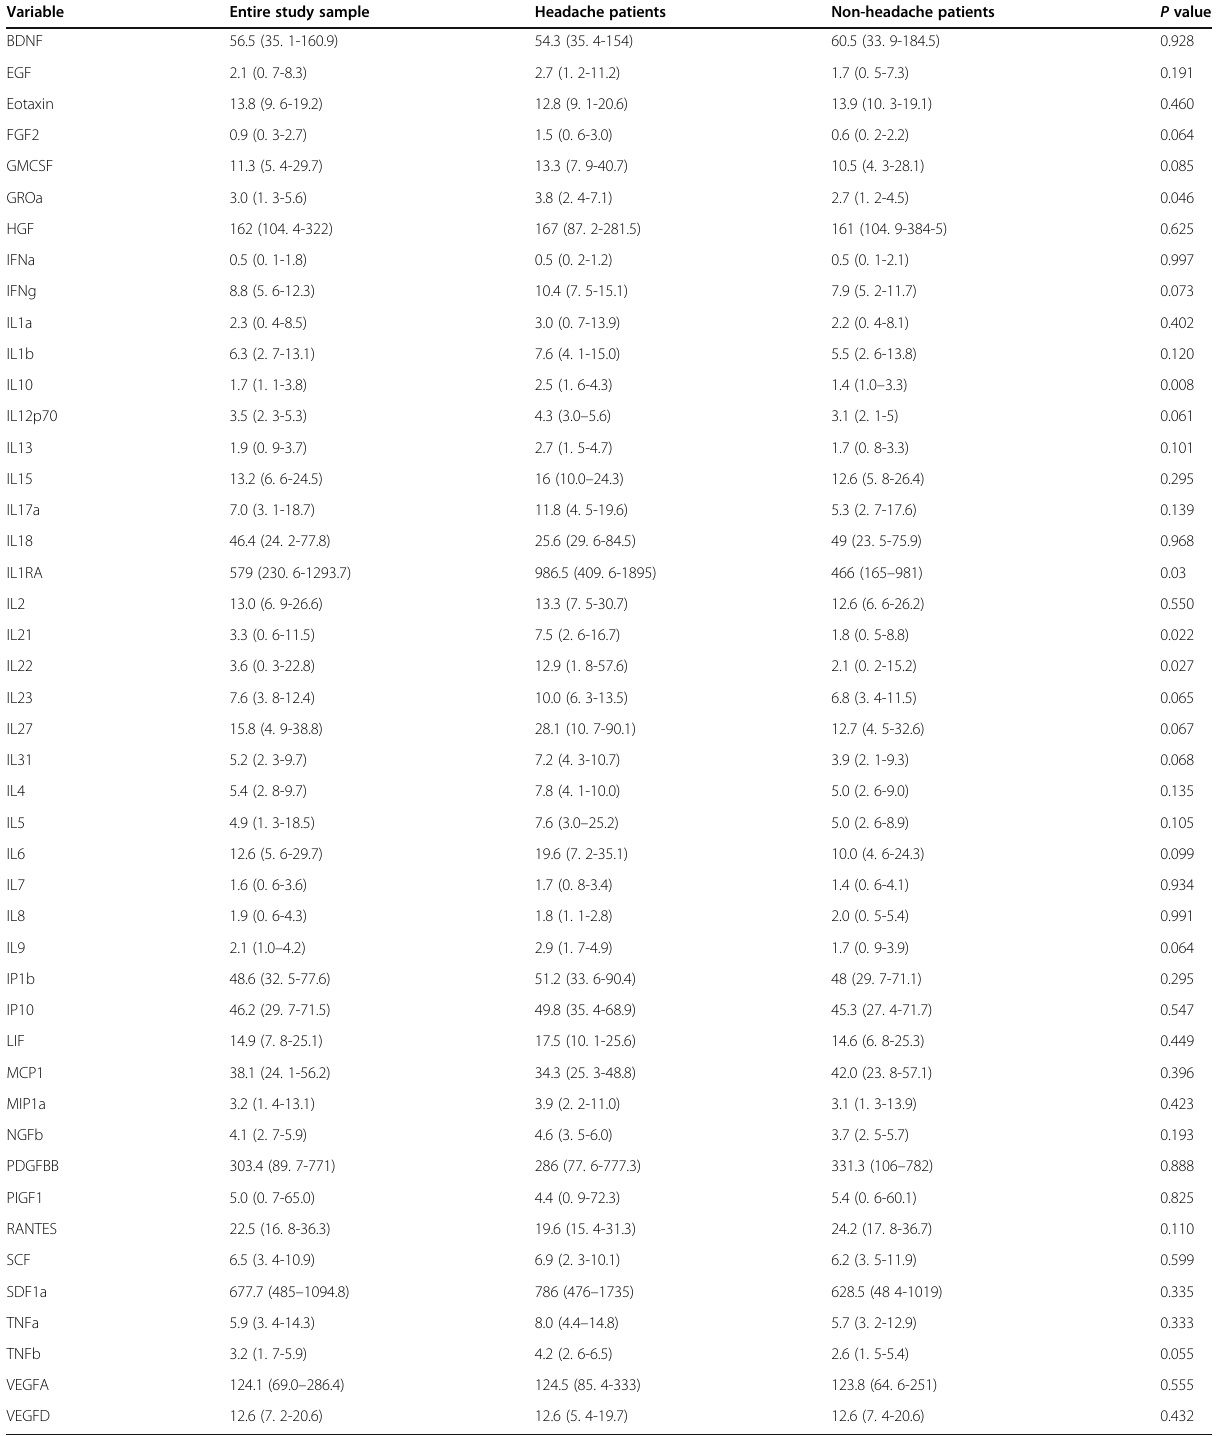
Table 3 Comparison of cytokines and interleukins by MWU test